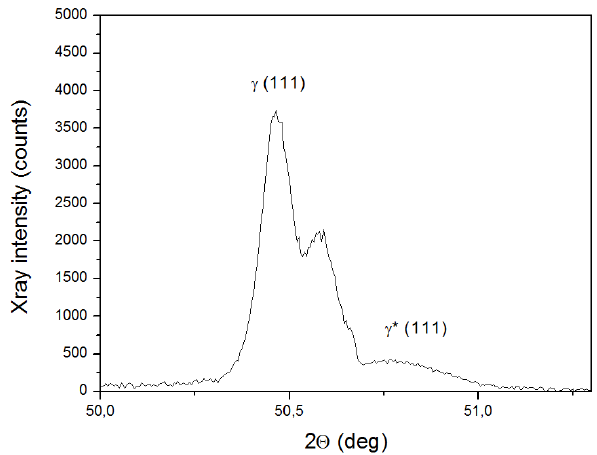
Figure 8. Contributions of γ and γ * to the precision (111) peak profile.